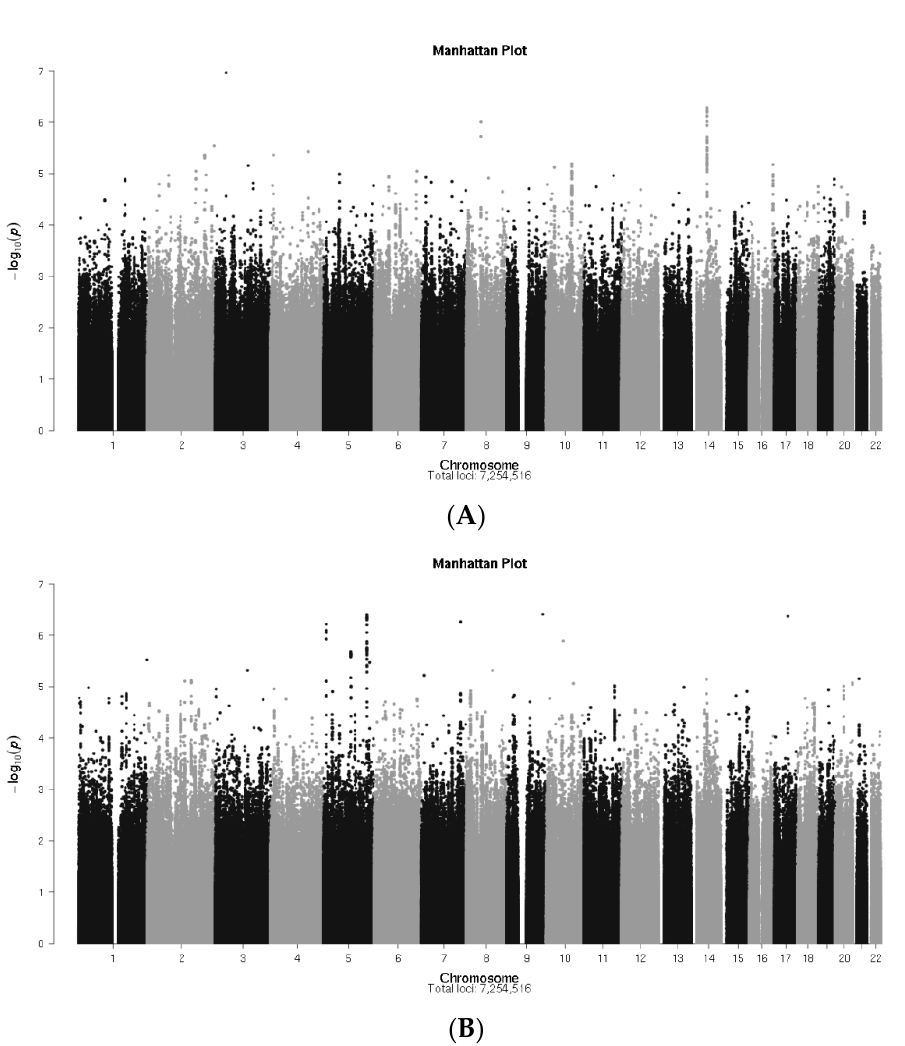
Figure 2. ( A ) Manhattan plot for genome ‐ wide associations with PROMIS ‐ 10 global physical health in MCBDR cohort. ( B ) Manhattan plot for genome ‐ wide associations with PROMIS ‐ 10 global mental in MCBDR cohort. ( B ) Manhattan plot for genome-wide associations with PROMIS-10 global mental health in MCBDR cohort. health in MCBDR